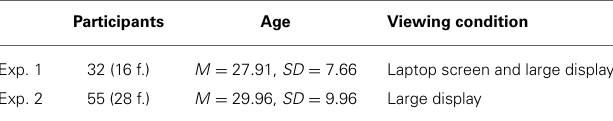
Table 2 | Participants of the experiment.